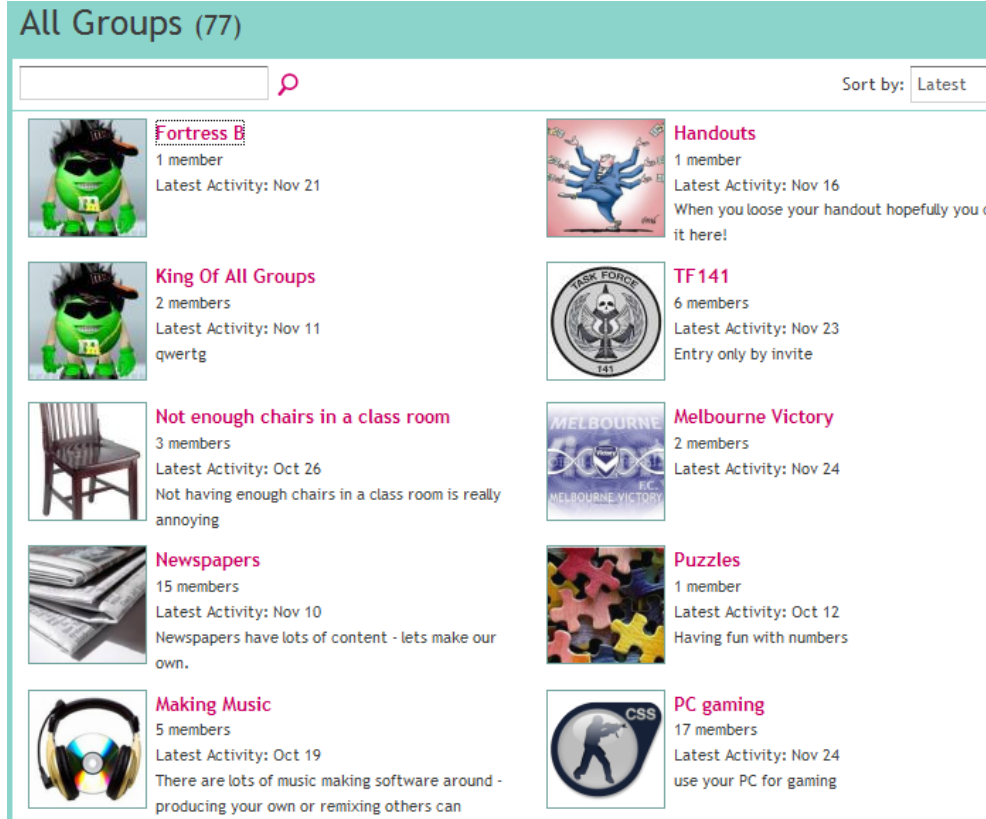
Figure 3. Screen clip showing a range of both student- and teacher-directed Ning groups. Example